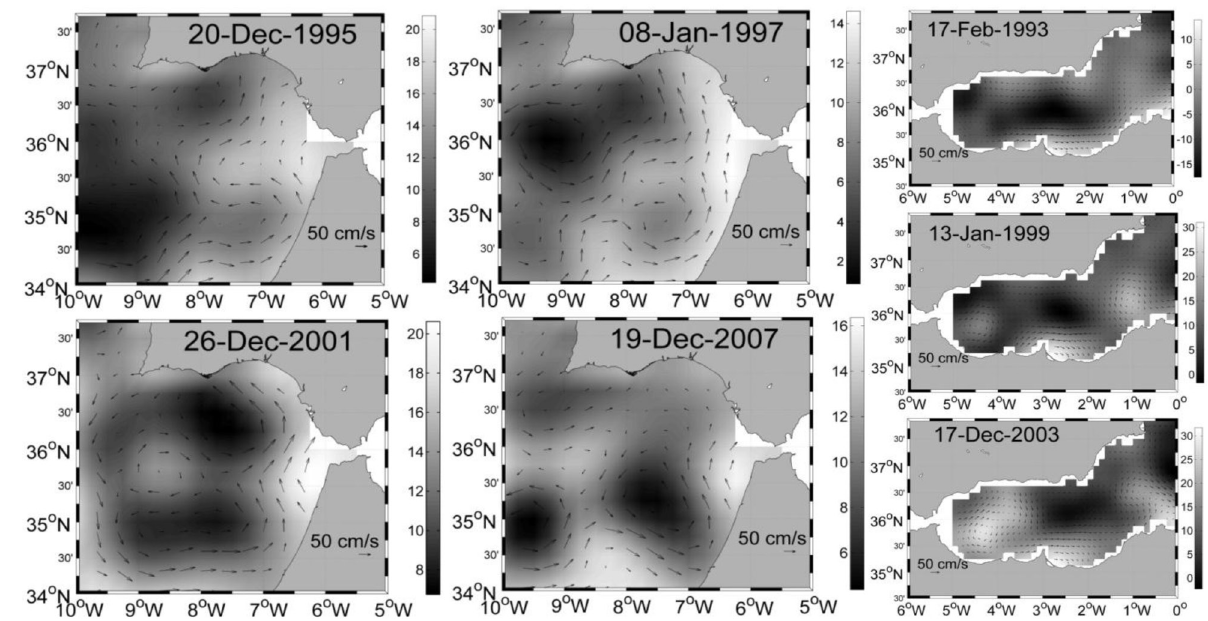
f iG . 6. – Left four panels: ADT and geostrophic currents in the GoC on the dates indicated in the panels, which coincide with the circles in Figure 5c. Right panels: same as above for AS. The dates in this case coincide with the circles in Figure 5g.